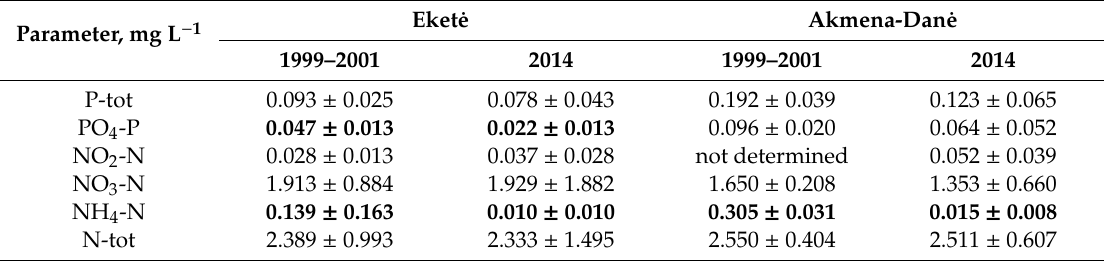
Table 1. The mean ( ± standard deviation) concentrations of nutrients in the waters of the Eket˙e River and the Akmena-Dan˙e River in 1999–2001 and 2014 (statistically significant di ff erences between the means are